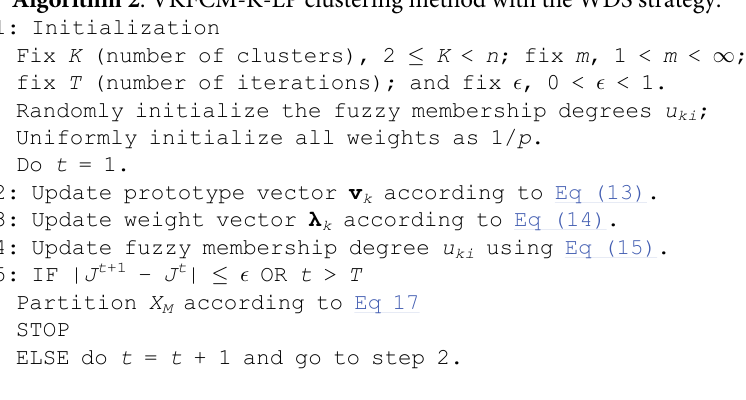
Algorithm 2 : VKFCM-K-LP clustering method with the WDS